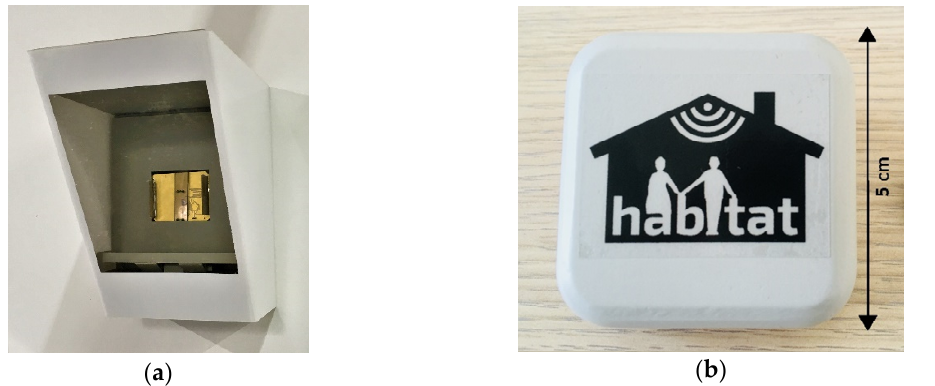
Figure 5. The adopted solution for embedding the smart objects in common objects of everyday life: ( a ) a wall lamp for the Radio Frequency Identification (RFID) reader and ( b ) a brooch, or a pendant, for the wearable tag.